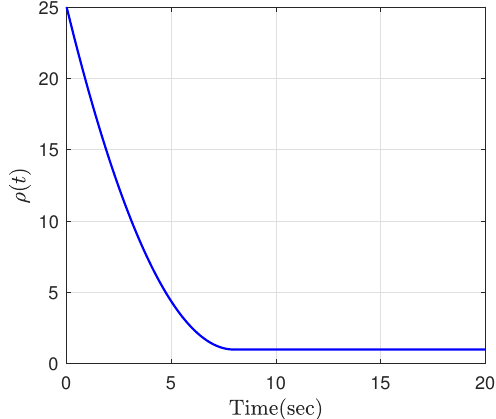
Figure 2. An example of ρ ( t ) in Equation